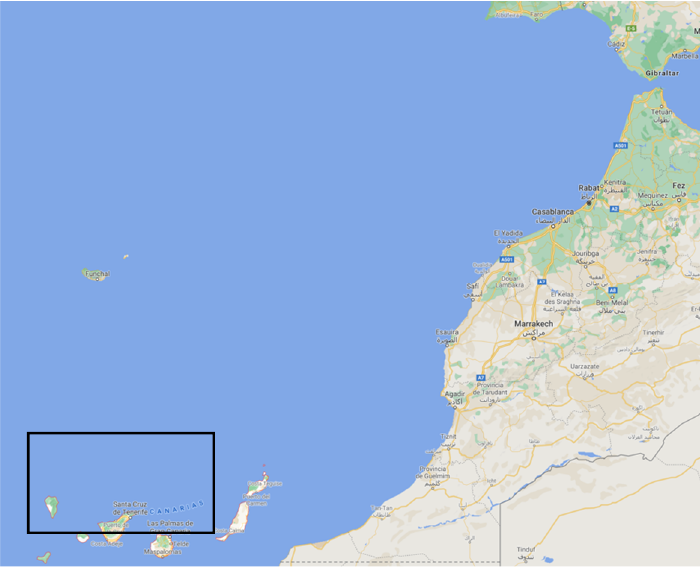
Figure 1. Geographical location of Canary Islands. Source: Google Maps. Edited by authors.